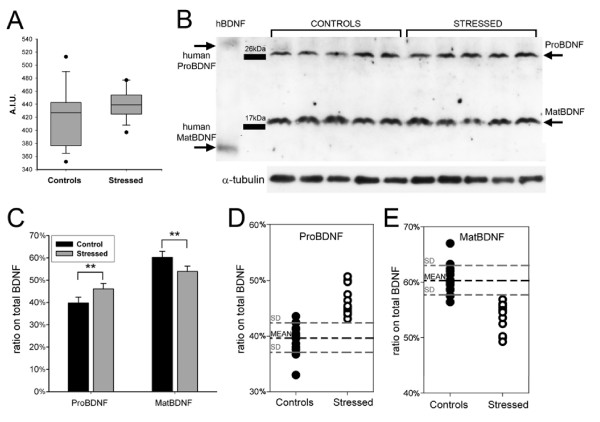
Stress increases significantly the percentage of proBDNF while decreasing matBDNF in the brain of stressed seabass. A) The quantification of total BDNF in the brain of seabass using an ELISA assay, showed no difference between control and stressed group (A.I.U. = arbitrary intensity units). B) A representative Western blot of proBDNF and mature BDNF expression in the seabass brain. Human proBDNF and mature BDNF is shown in the first lane from left. Alpha-tubulin used for normalization is shown at the bottom. C) ProBDNF on total BDNF is significantly increased (** = p < 0.01) in stressed animals with respect to control animals and mature BDNF percentage is increased (** = p < 0.01; n = 15 animals, each in duplicate. Error bars are SE). D) The scatterplot shows that in the brain of all stressed animals proBDNF are above the mean of controls+1SD. E) Similarly, in all stressed animals mature BDNF values are below the mean of controls -1SD. Only 2 control animals have a proBDNF percentage above the controls' mean+1SD for proBDNF or below the mean-1SD. The F values, obtained by One way Anova analysis, for proBDNF and mature BDNF were 19.028 and 6.225, respectively.